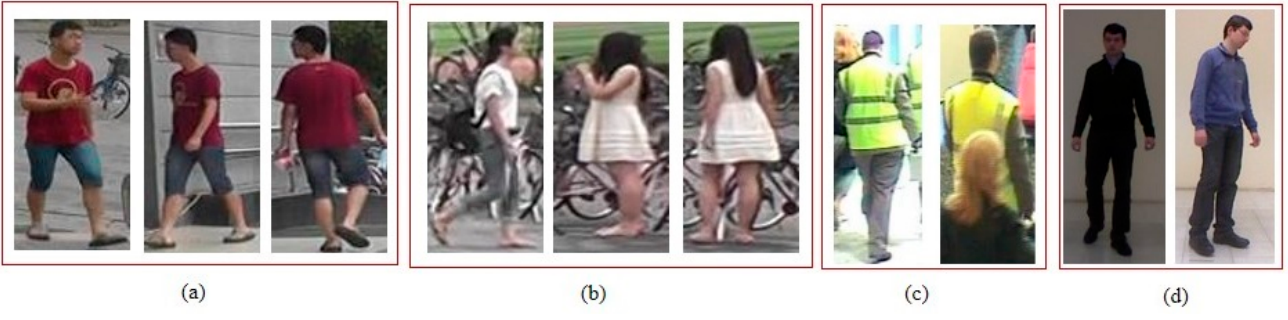
Figure 1. Sample images showing the challenges related to camera variations and environmental conditions in the Re-ID problem. ( a ) shows pose and viewpoint variations; ( b ) background clutter; ( c ) partial occlusion; and ( d ) illumination variations. Images were taken from the public standard datasets IAS-Lab [14], i-LIDS [15] and Market-1501 [16].